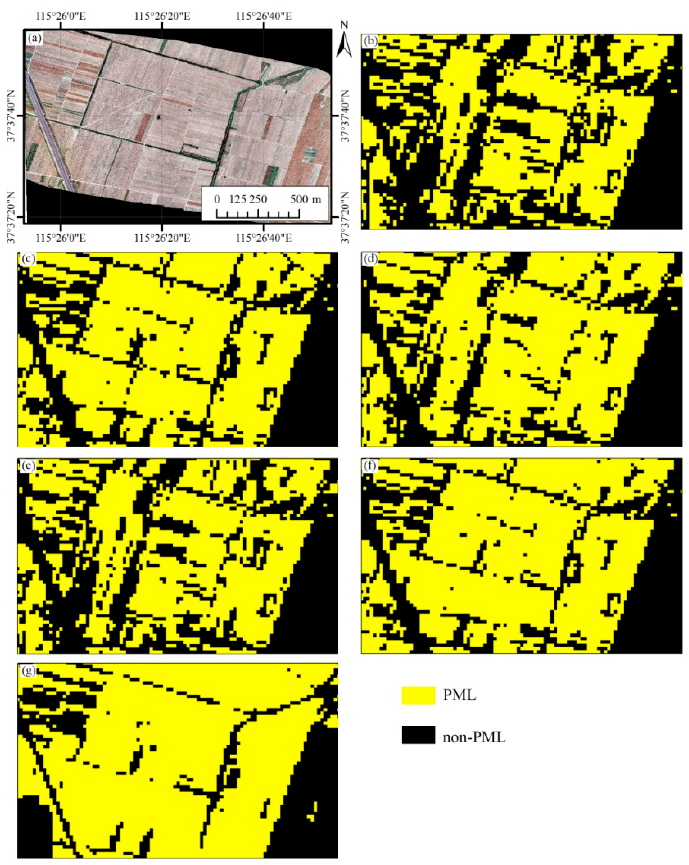
Figure 7. Visual comparison of PML mapping results in the first subset region of HS. ( a ) The Unmanned Aerial Vehicle (UAV) images were acquired on June 8 2018 and the white pattern in the figure is PML. ( b ) PML mapping results of PMLI using the MTPML workflow. ( c ) PML mapping results of PMLI_NIR using the MTPML workflow. ( d ) PML mapping results of PMLI_SWIR using the MTPML workflow. ( e ) PML mapping results of PMLI_ND using the MTPML workflow. ( f ) PML mapping results of RF using the MTPML workflow. ( g ) PML mapping results of SUPML.